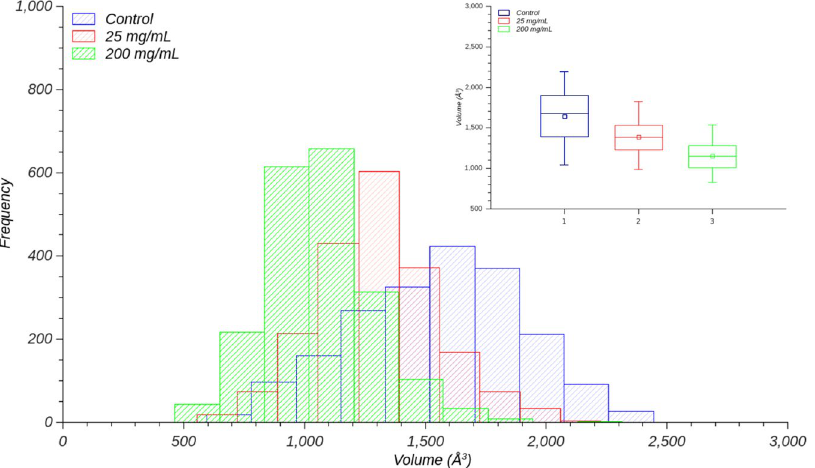
Figure 5. Distribution of the volume of InhA active site cavity for subunit A. The bars for the simulation at sucrose concentration of 200 mg mL − 1 are colored in green, in red is given the simulation for sucrose at 25 mg mL − 1 , and the control is shown in blue. Top right inset presents a box plot with the mean and variance of the values to all systems. Image prepared with QtiPlot 29